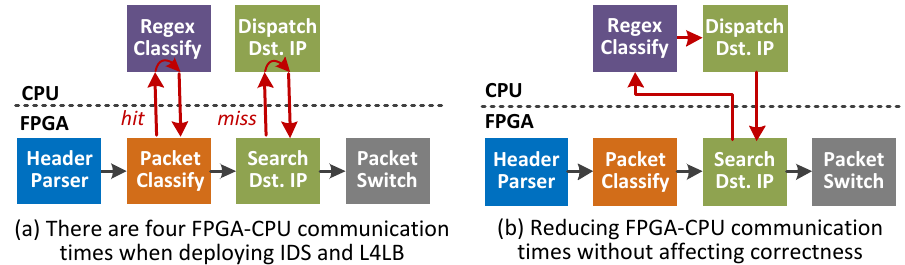
Figure 2. It is necessary for several FPGA-CPU communication times when deploying multiple NFs. Therefore, we should reduce FPAG-CPU communication times without affecting correctness.